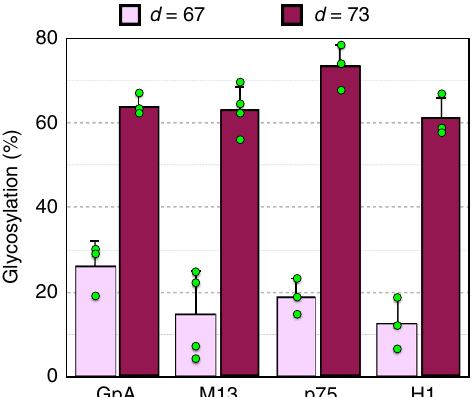
Fig. 3 TM helices from different origins display a compact conformation. Glycosylation percentage of nascent polypetides with 67 (pink) or 73 (purple) residues between the acceptor Asn and the polypeptide C- terminus. Error bars represent the mean ± SD; n ≥ 3. Individual data points are shown as green dots. Sequences and full glycosylation patterns can be found as Supplementary Fig. 7. Source data are provided as a Source Data fi le sequences gp41 and VSV-G, ΔΔ SASA is negative, indicating that the helical state is stabilized by hydrophobic contacts in the ribosome exit tunnel more than the extended state (see Fig. 2). For the soluble sequences NAGK and L9, ΔΔ SASA is close to zero or only slightly negative, indicating that the extended state is neither favored nor disfavored compared to the folded state. Fig. 5. For the TM sequences, given the high number of possible Fig. 3, all four constructs harboring TM sequences show a clear